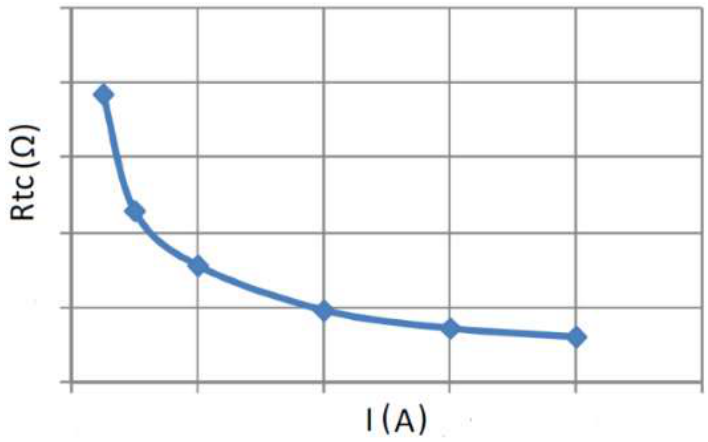
Figure 3. Generic curve of charge transfer resistance ( R tc ) vs Current.